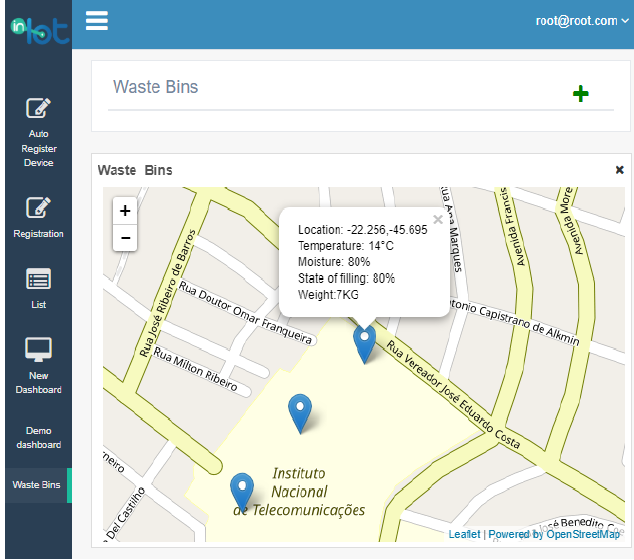
Figure 5. Image from the In.IoT middleware platform showing the location of smart bins.